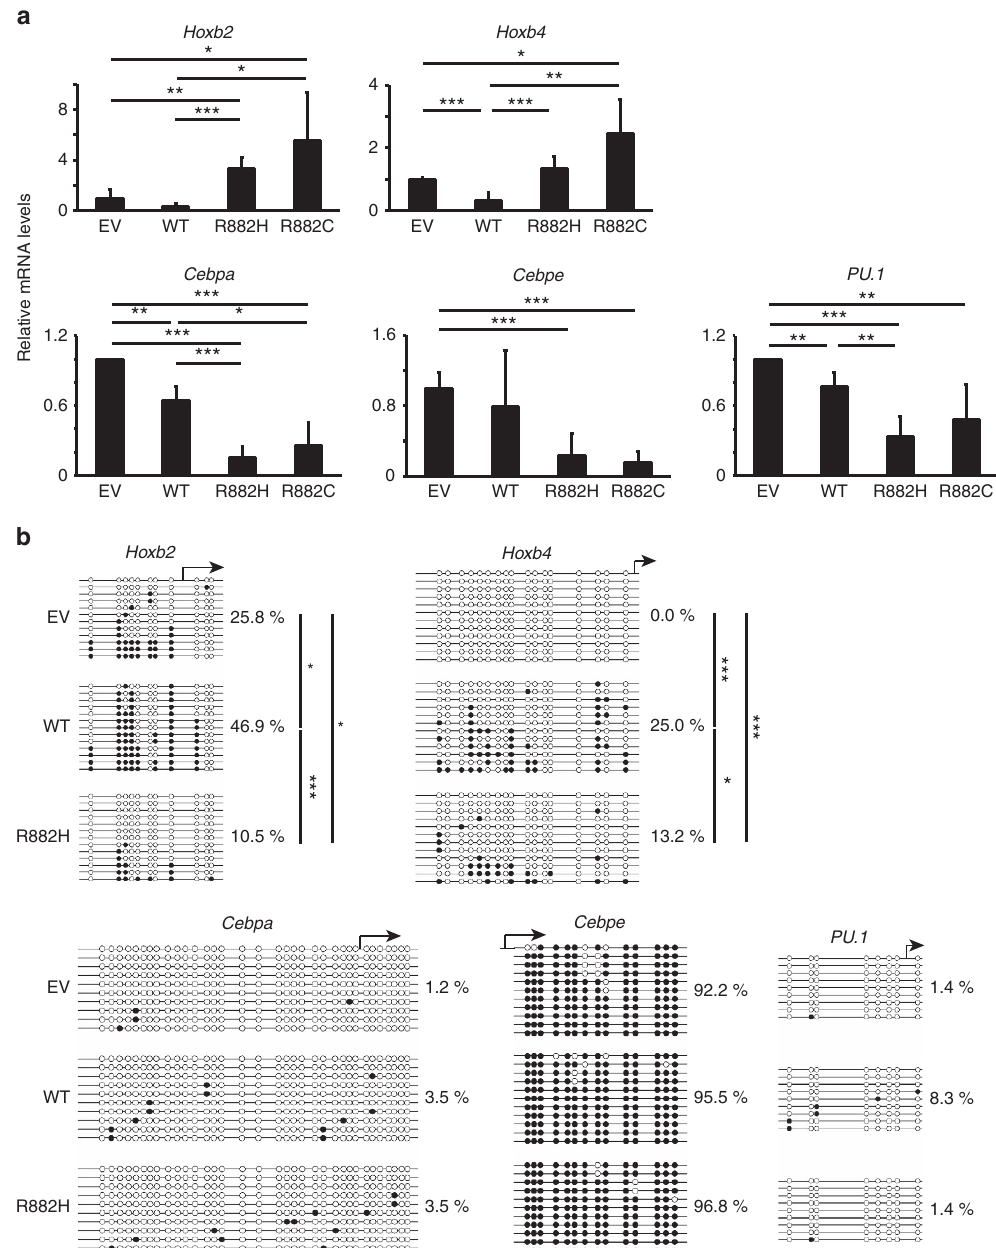
Figure 2 | DNMT3A mutant downregulates differentiation-associated genes in a DNA methylation-independent manner. ( a ) Relative expression levels of Hoxb2 , Hoxb4 , Cebpa , Cebpe and PU.1 in GFP þ LSK cells measured by qPCR. ( N ¼ 5 replicate experiments except for R882C ( N ¼ 3), normalized to the expression levels in EV-transduced LSK cells.) P values were calculated using two-tailed unpaired t -test. ( b ) Bisulfite sequencing analysis of promoter- associated CpG island of Hoxb2 , Hoxb4 , Cebpa , Cebpe and PU.1 in GFP þ LSK cells. Arrows represent transcription start sites. Open and filled circles represent unmethylated and methylated CpGs, respectively. P values were calculated using Mann–Whitney U test. LSK, Lineage (cid:2) , Sca1 þ , c-kit þ ; qPCR, quantitative polymerase chain reaction. Data are mean ± s.d. values. * P o 0.05, ** P o 0.01, *** P o